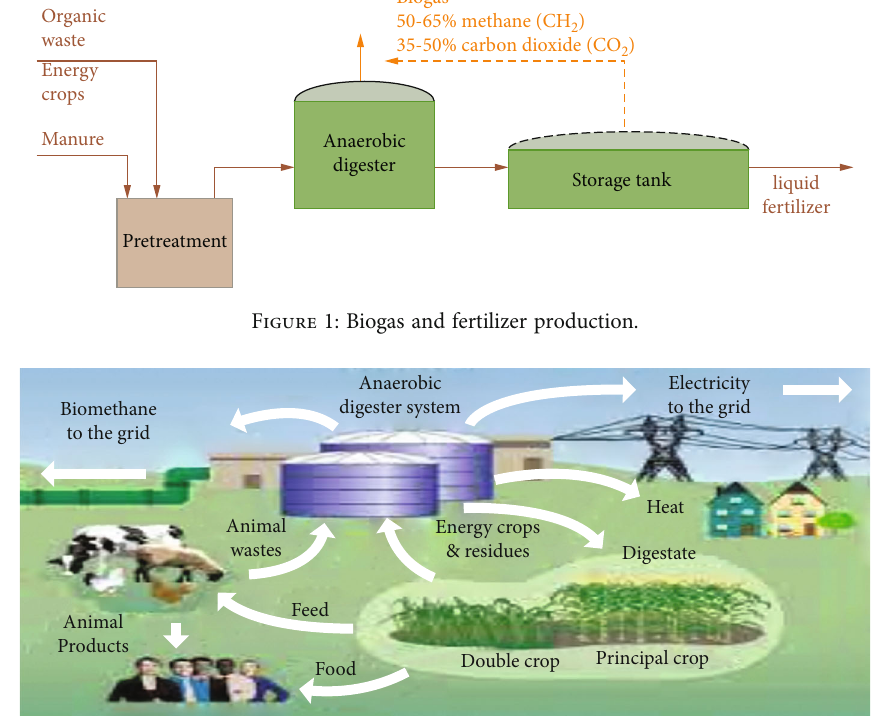
Figure 2: Diversi fi ed biogas production with fertilizer, lighting, and electricity